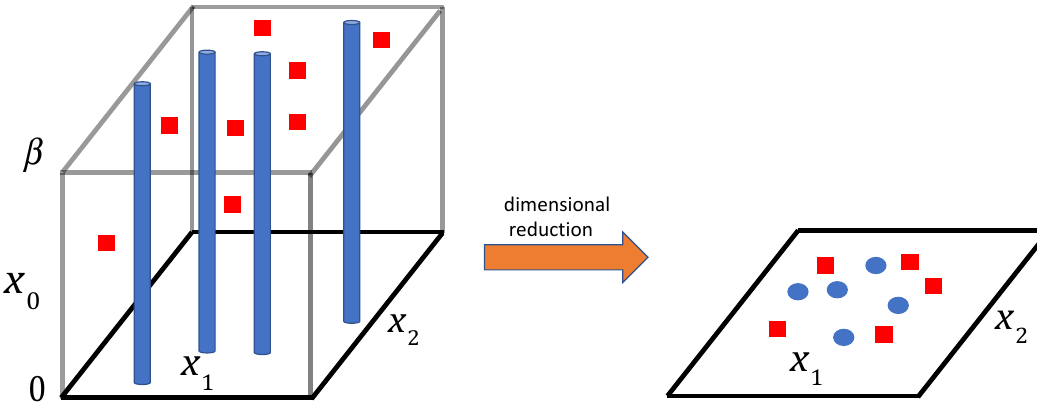
Figure 1 . The 3-D system at (cid:12)nite temperature consists of W-bosons (represented by blue vortices) and instantons (represented by red square). The W-bosons are genuine particles, and hence, they trace worldlines (these are the blue vortices). In addition to the W-bosons we have instantons, which appear as localized objects in the Euclidean space. At (cid:12)nite temperature we identify the time-direction x 0 = 0 (cid:12) and the worldlines of W-bosons become closed circles. Near the transition (cid:24) we can neglect all the Matsubara modes keeping only the zero mode; the system becomes e(cid:11)ectively a 2-D Coulomb